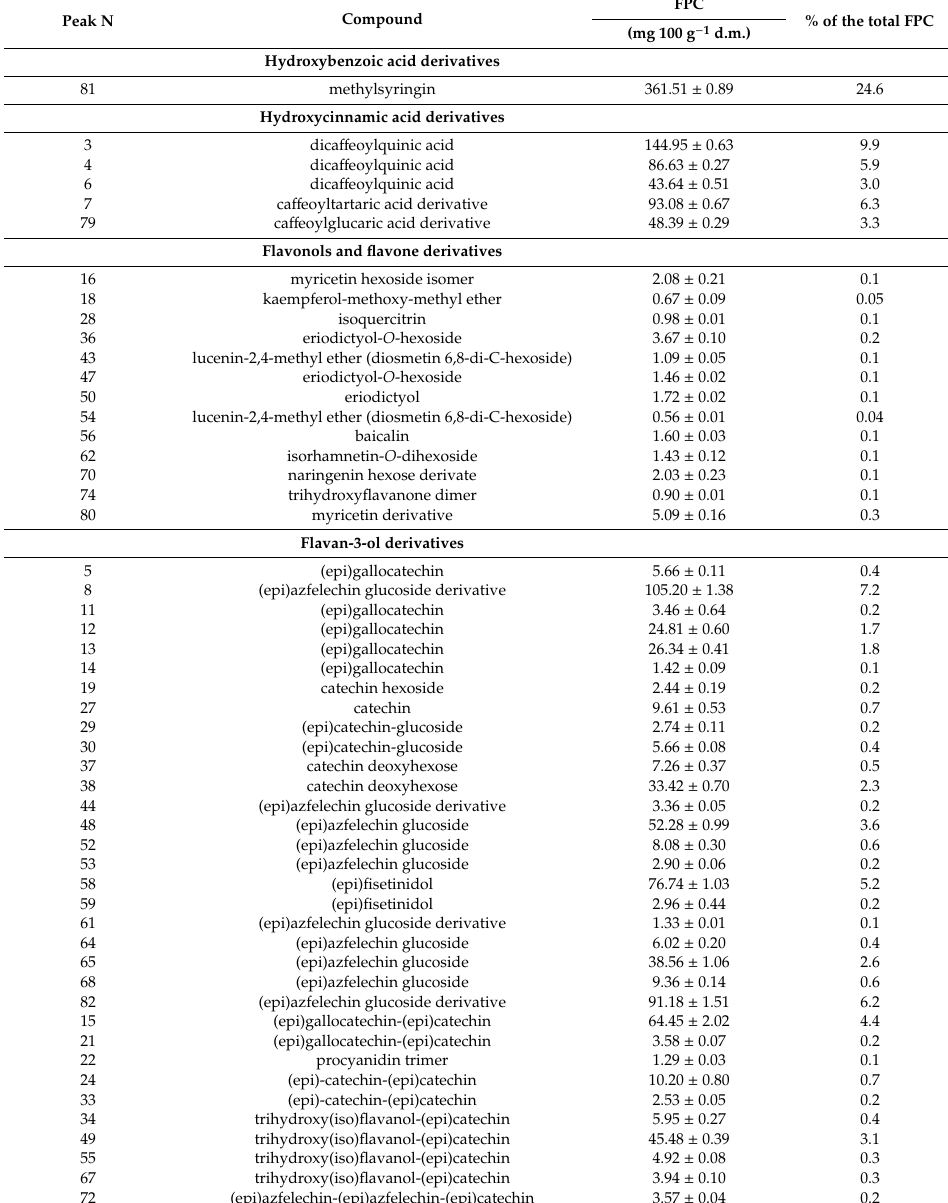
Table3. Quantificationoffreephenoliccompounds(FPC)ofbananapassionfruitpulp(mg100g − 1 d.m.). Peak N